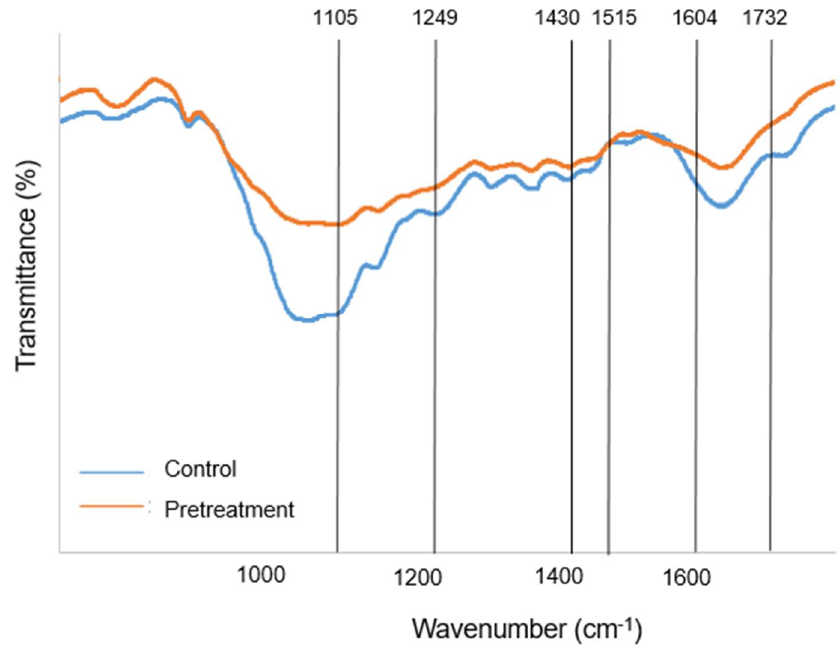
Figure 2. FTIR analysis of [Ch][OAc]-pretreated sample with selected wavenumbers representing changes in the functional groups of lignocellulose biomass.